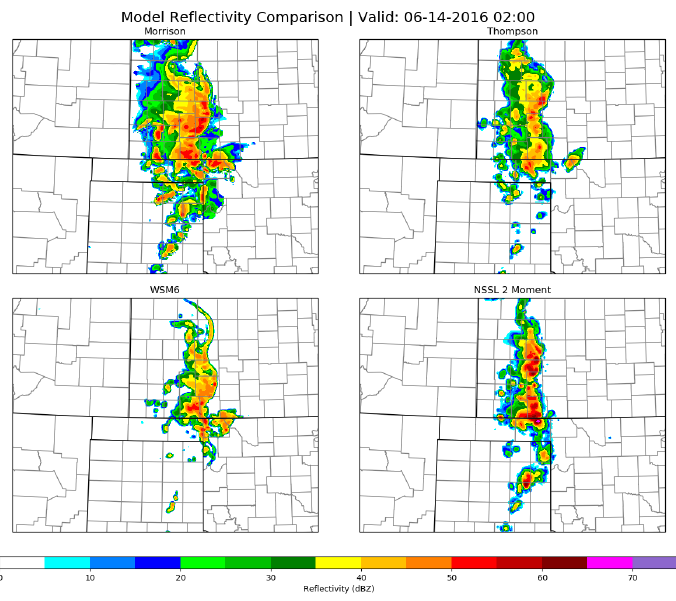
Figure 7. Same as Figure 6, but for nine hours after convective initiation. Images are 14-h WRF forecasts valid at 0200 UTC.